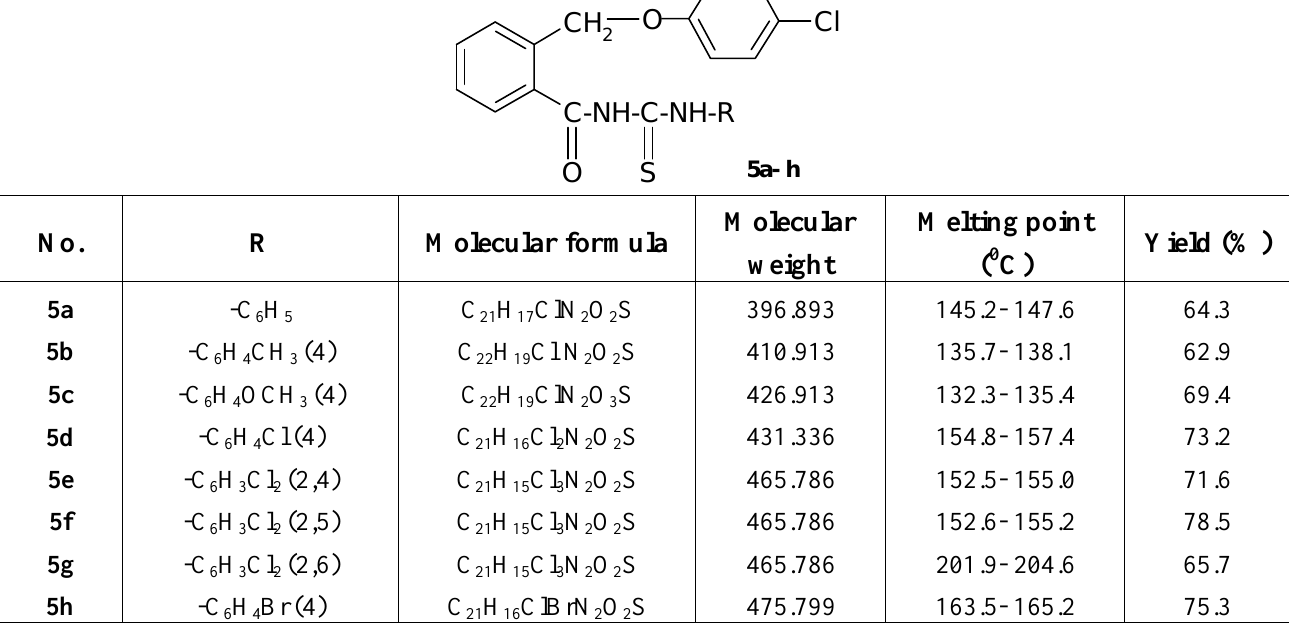
Table 1. Characteristics of the new